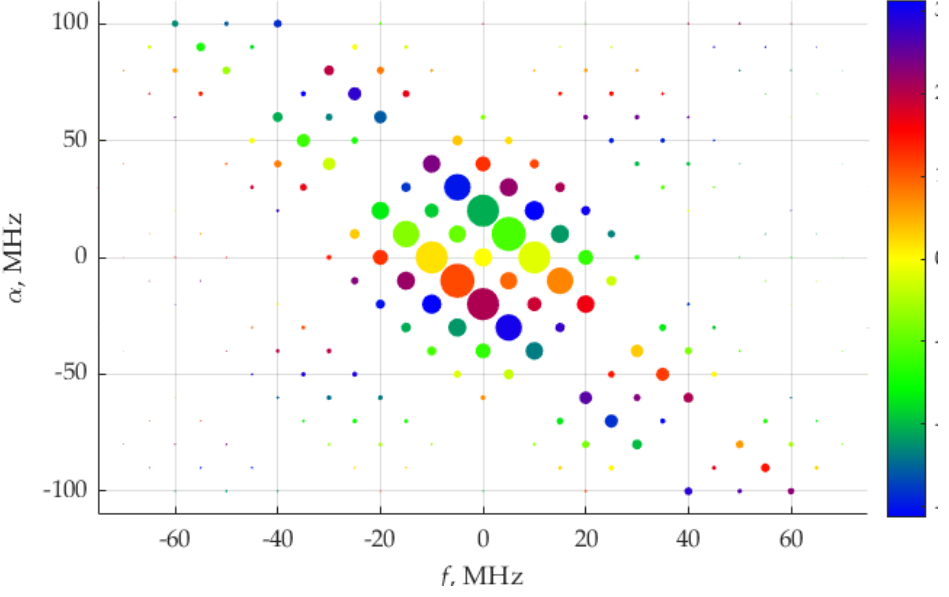
Figure 11. Diagram of CSCD for the case of pulse train current.